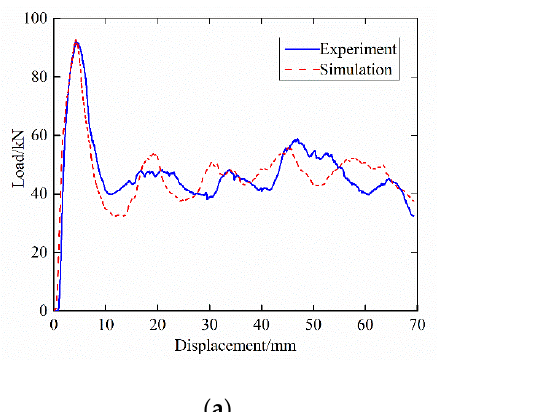
Figure 8. Simulation and experiment comparison of the CFRP tube: ( a ) load – displacement curve; ( b ) comparison of defor- mation modes.